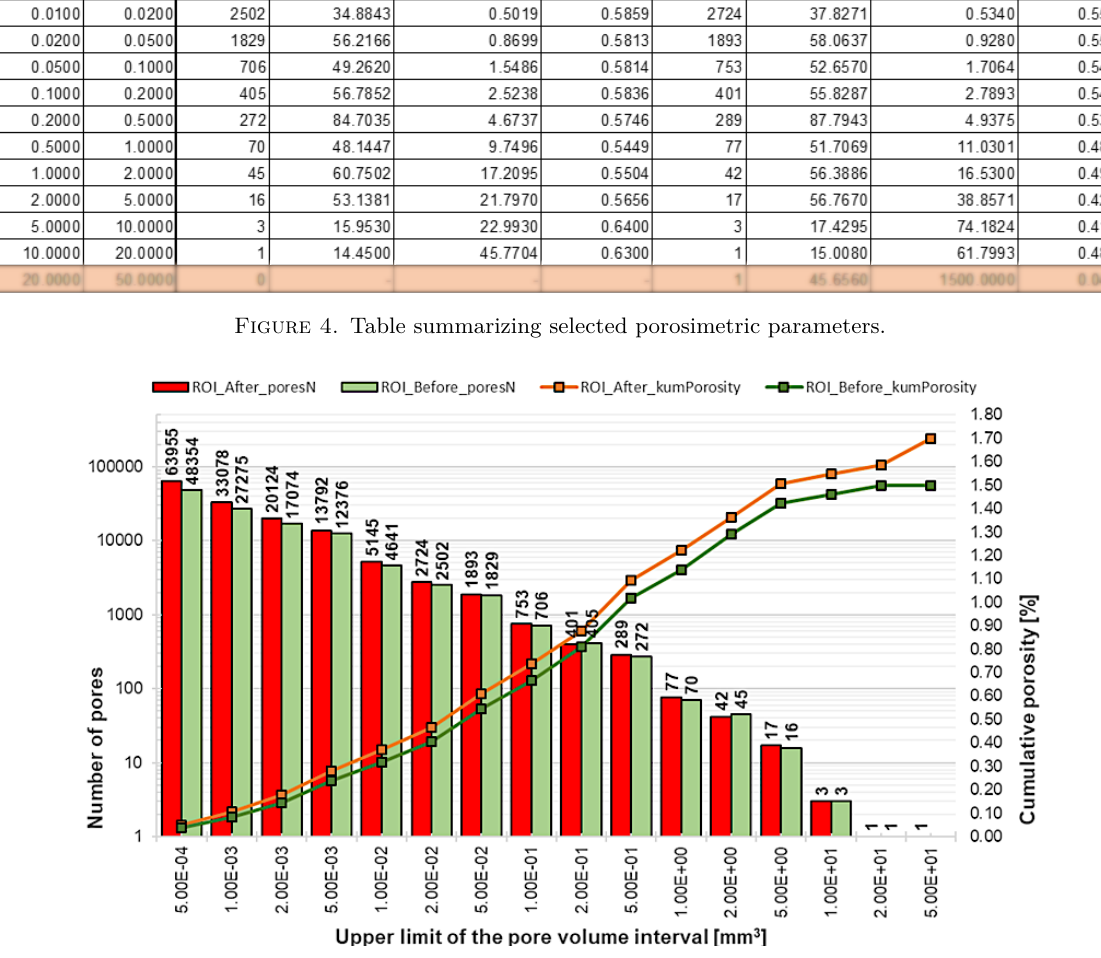
Figure 5. Graph of the porosimetric results. Bars in the graph represent histogram of the pore distribution within the investigated ROI before and after the three-point bending fracture test. Curves on the secondary axis represent the cumulative porosity at each pore volume